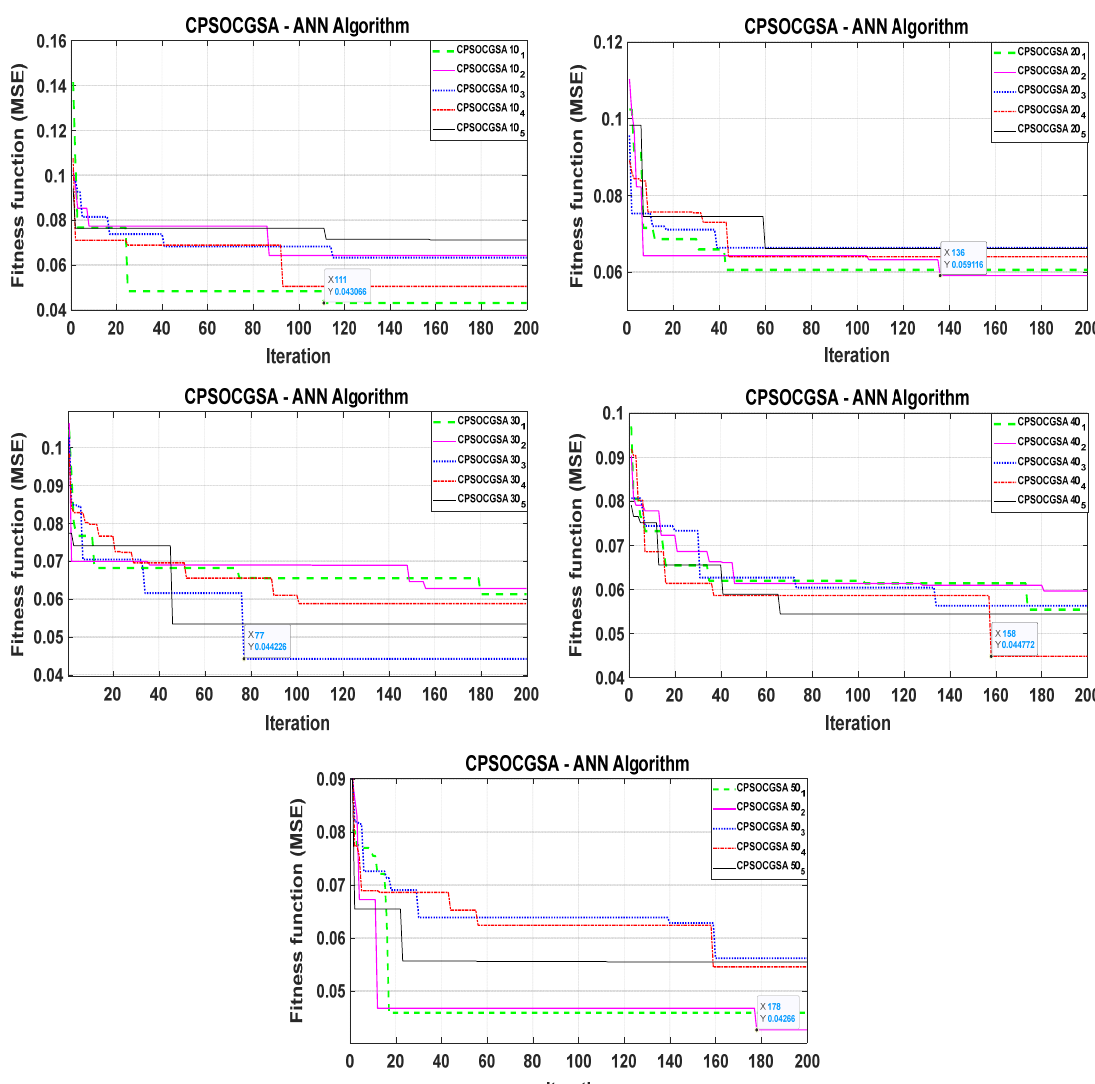
Figure 5. Performance of the CPSOCGSA algorithm for SPI 1.